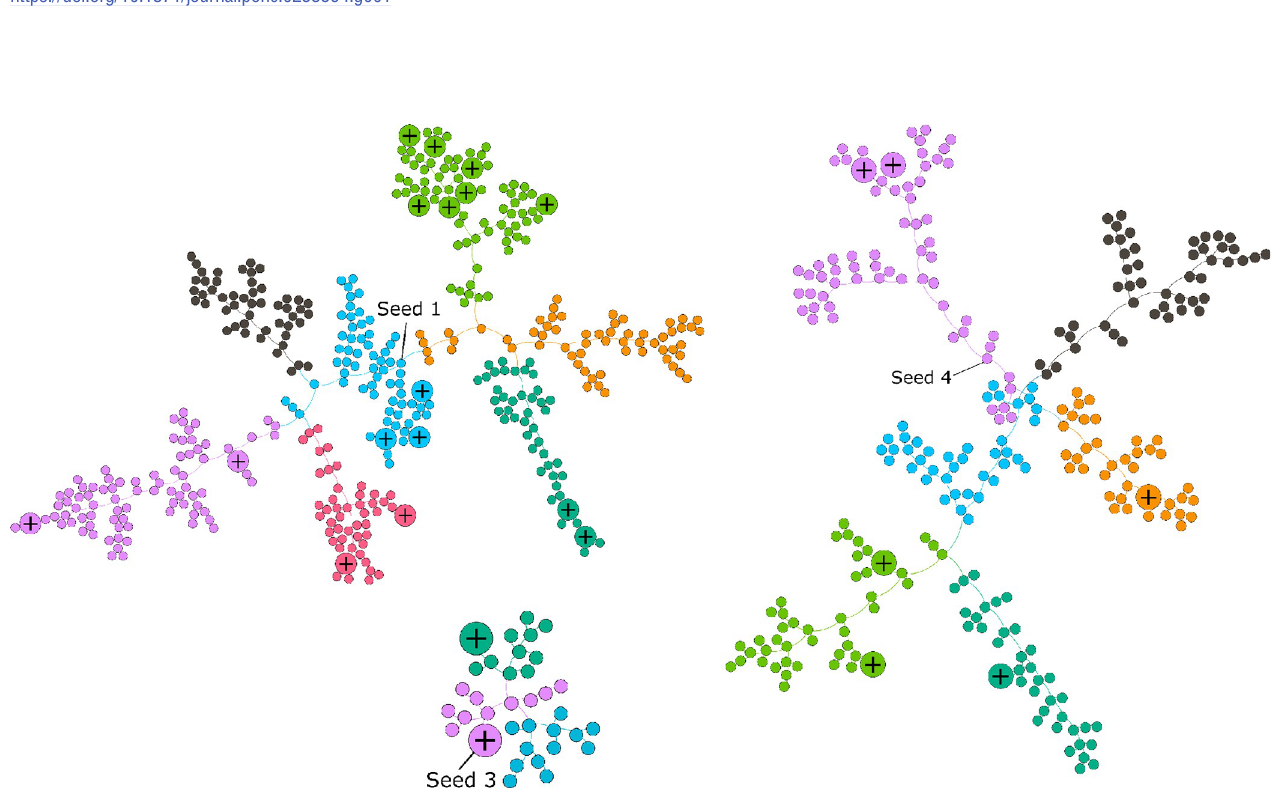
Fig 2. Seeds 1, 3, and 4, the largest networks of HET4 cycle. The positive signs indicate the HIV positives in the networks.